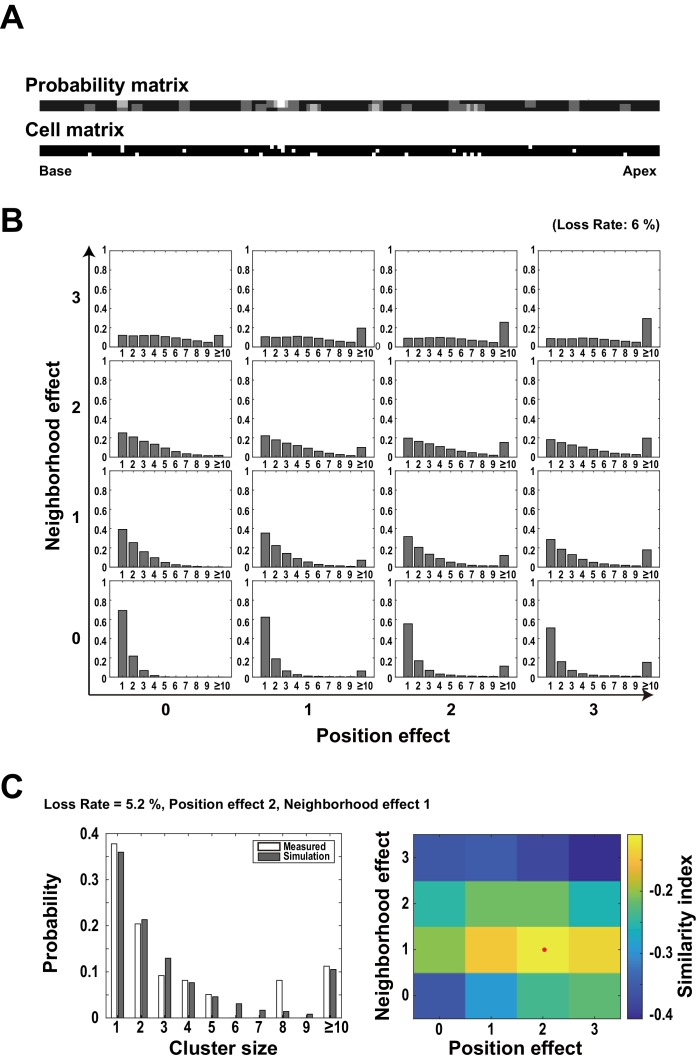
Simulation analysis of clustered cell loss.(A) A pair of ‘probability matrix’ (upper panel) and ‘cell matrix’ (lower panel). The intensities of elements in the ‘probability matrix’ indicate the probability of cell loss for the next round of the simulation runs for individual cells. White pixels in the ‘cell matrix’ indicate the locations of already lost cells in previous rounds of the simulation runs. (B) An example of simulated histograms with different amounts of two effects (neighborhood effect and position effect). These histograms indicate the frequency distribution of cell loss clusters with different sizes. (C) Comparison of experimental data and simulation results for a given cochlear sample (No. 517). A heat map (right) shows the relative similarities between the experimental data and the simulation result (reverse of the error score in Figure 4C) when the weights of the neighborhood effect and the position effect were systematically changed. The weighted average point indicated by the red dot was taken as the estimated contributions of two effects to this sample.